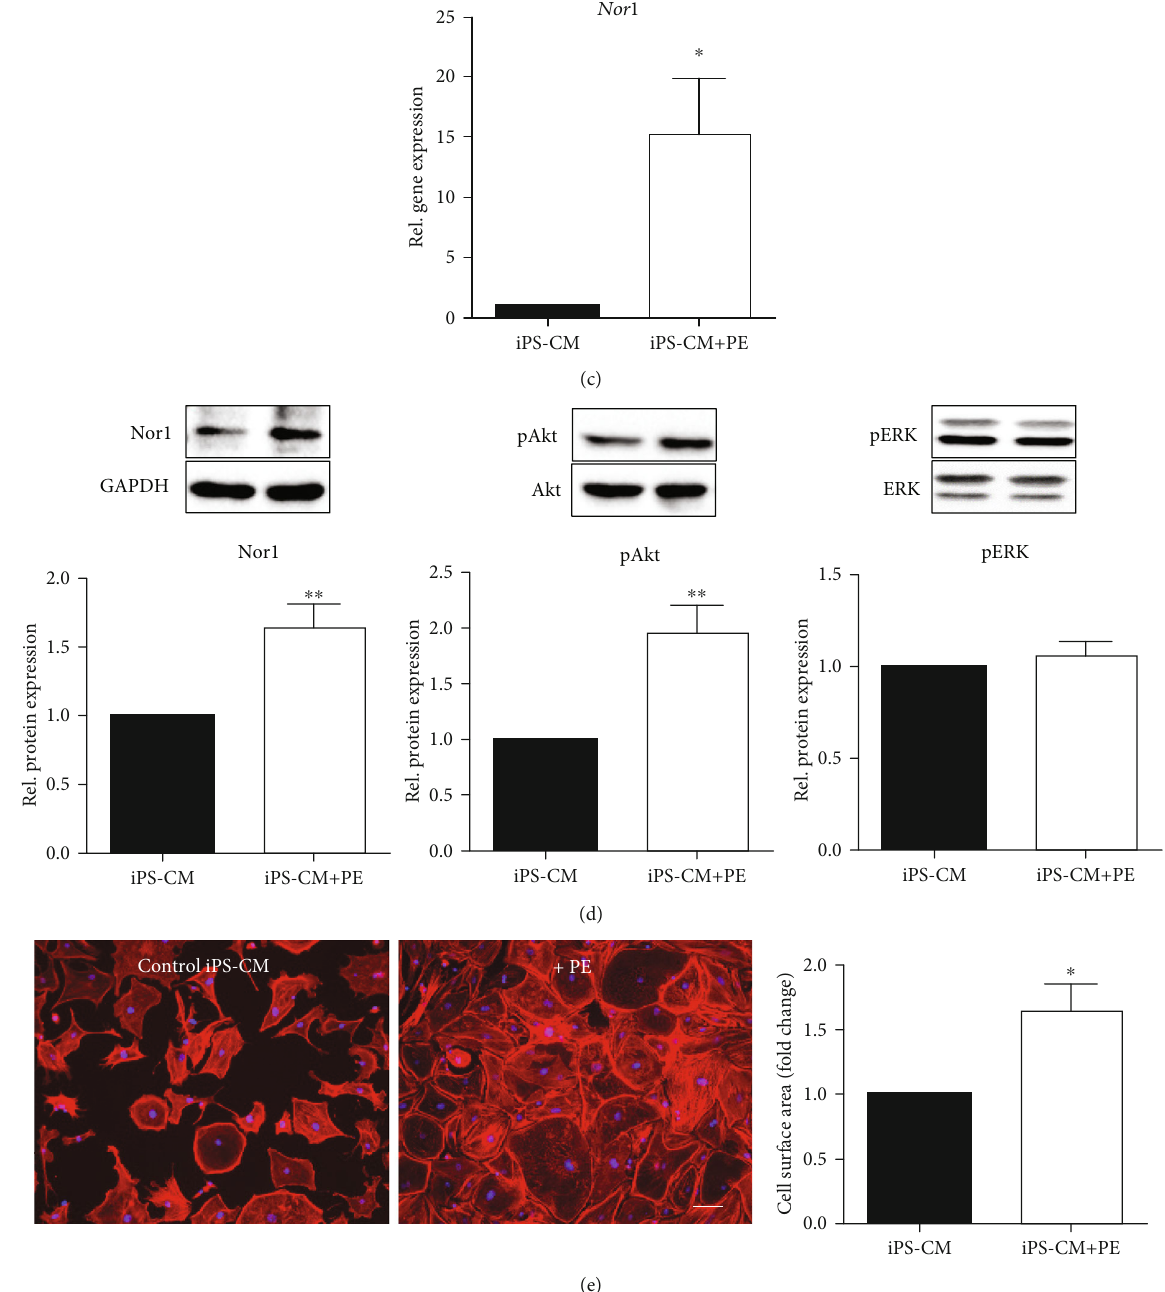
Figure 1: Characterization of hypertrophied iPS-CM. iPS-CM were cultured in the presence of 100 μ M phenylephrine (PE) to induce hypertrophy. (a) Scatter plot of microarray data showing log2 of the gene transcripts between iPS-CM and iPS-CM treated with PE. (b) Top 30 up- and downregulated genes in PE-treated iPS-CM. Additional signi fi cantly upregulated genes involved in hypertrophic cell growth are highlighted by the dotted square. (c) Nor1 gene expression was veri fi ed by real-time PCR. n = 5 . (d) Western blot analysis of Nor1 ( n = 8 ), normalized to the expression levels of GAPDH. The expression of phosphorylated Akt (pAkt, n = 8 ) and phosphorylated Erk (pERK, n = 4 ) in hypertrophied iPS-CM was normalized to that of the unphosphorylated forms. (e) iPS-CM were seeded on fi bronectin- coated coverslips and treated with 100 μ M PE for 24h. Cells were further fi xed and incubated with Alexa Fluor 555 phalloidin to stain intracellular F-actin (red). Nuclei were counterstained with DAPI (blue), and the cell area was quanti fi ed microscopically. Bar: 100 μ m; n = 7 . ∗ p < 0 : 05 , ∗∗ p < 0 : 01